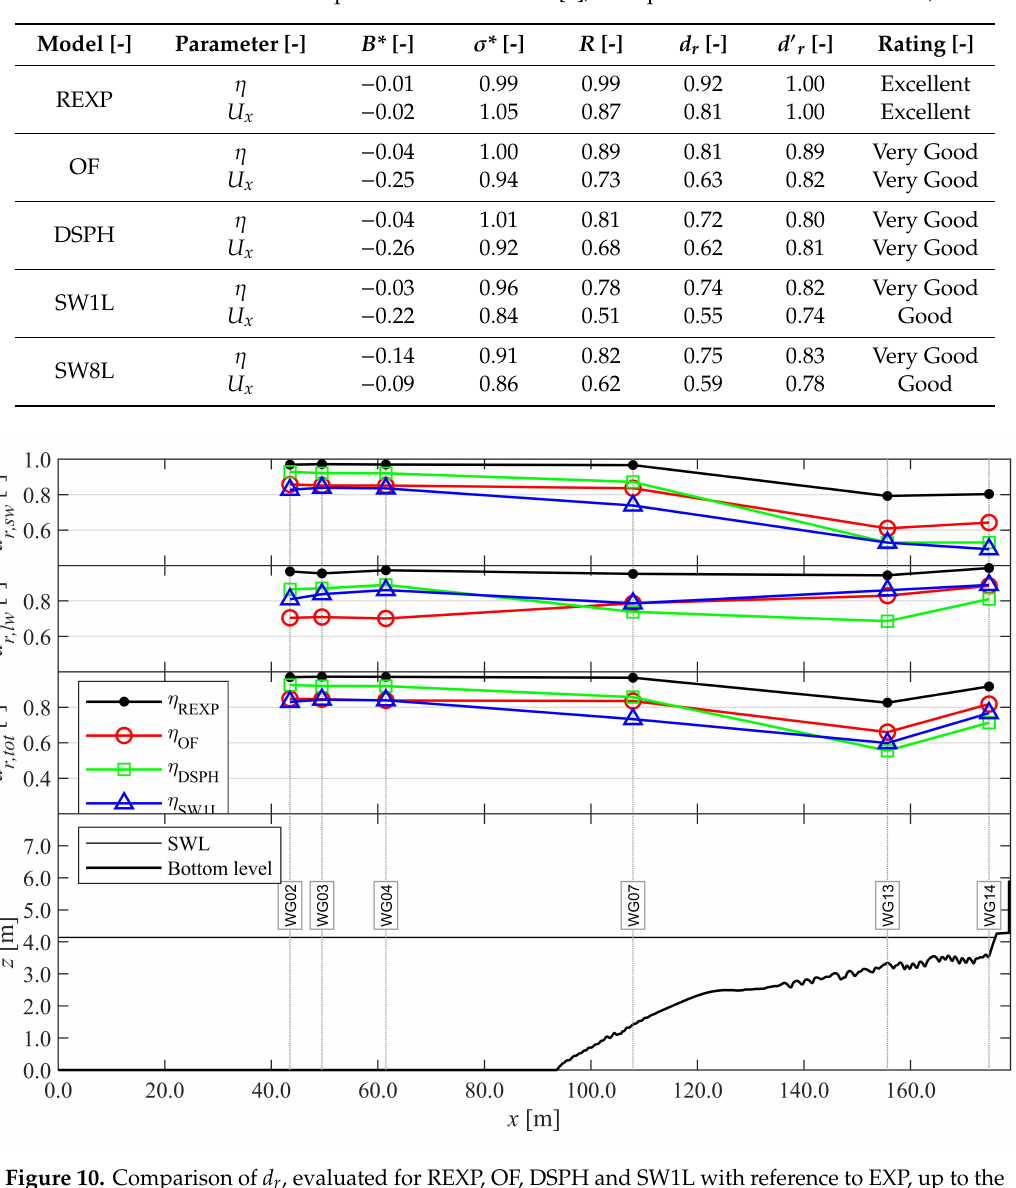
Table 3. Model performance and pattern statistics evaluated for η of REXP, OF, DSPH, SW1L and the measured location ECM. Adapted from the work in [3], with permission from the authors, 2020.